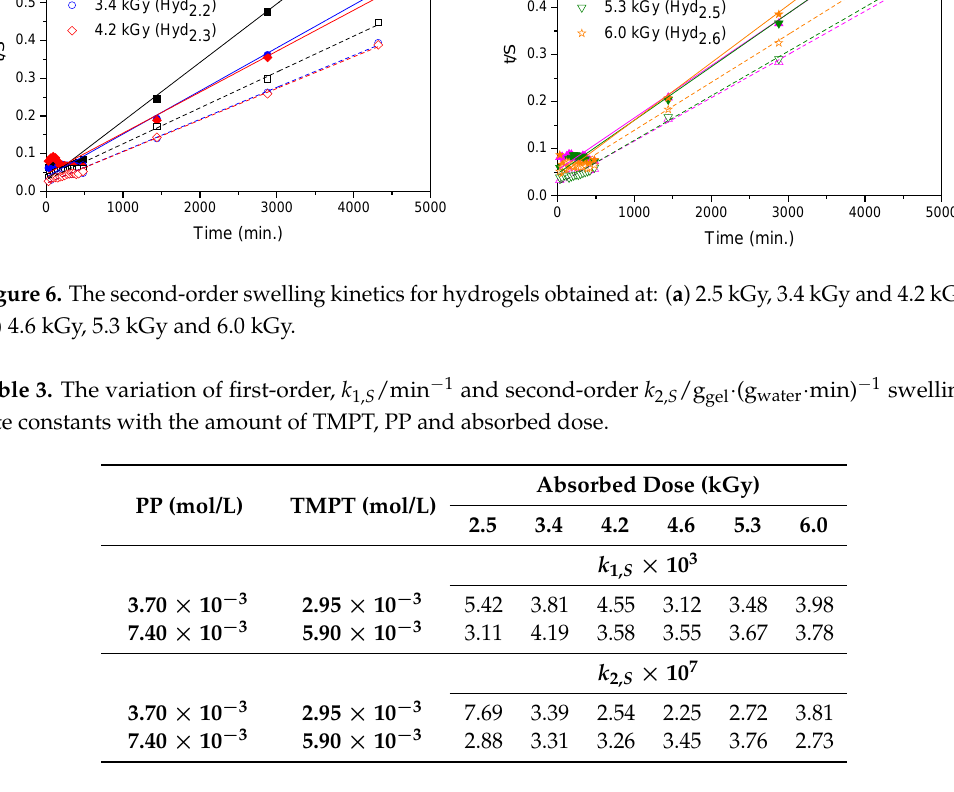
Table 4. The variation of initial swelling rate, r 0 /g water · (g gel · min) − 1 and equilibrium swelling degrees (theoretical) S max. /g water · (g gel ) − 1 with the amount of TMPT and absorbed